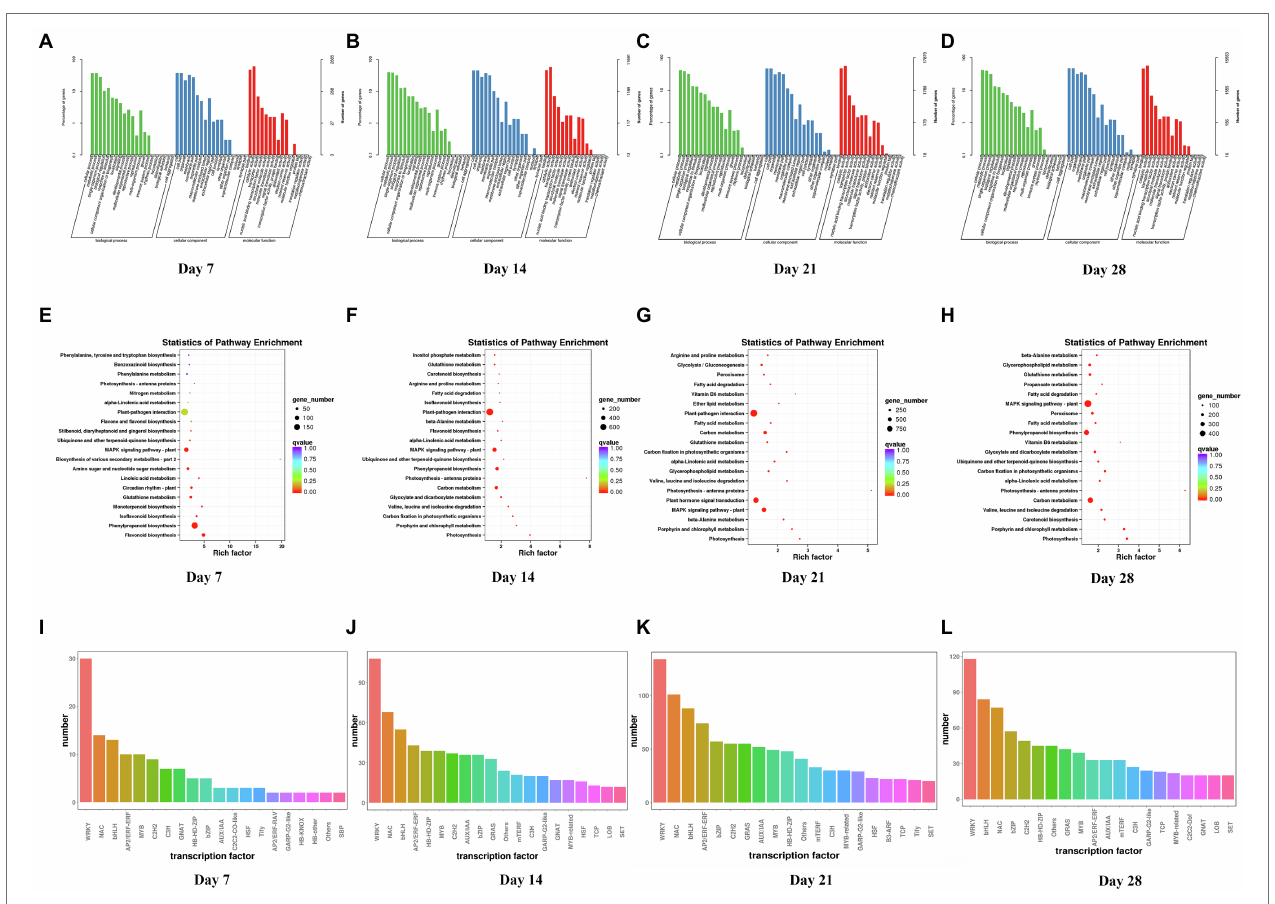
FIGURE 2 | GO classification, KEGG enrichment analysis and transcription factor prediction of DEGs between WL343HQ inoculated with Verticillium alfalfae (WL + V) and control group (WL) on days 7, 14, 21, and 28. (A–D) GO classification of DEGs on days 7, 14, 21, and 28. (E–H) KEGG enrichment analysis of DEGs on days 7, 14, 21, and 28. (I–L) Transcription factor prediction of DEGs on days 7, 14, 21, and 28. n = 3 per group for each time